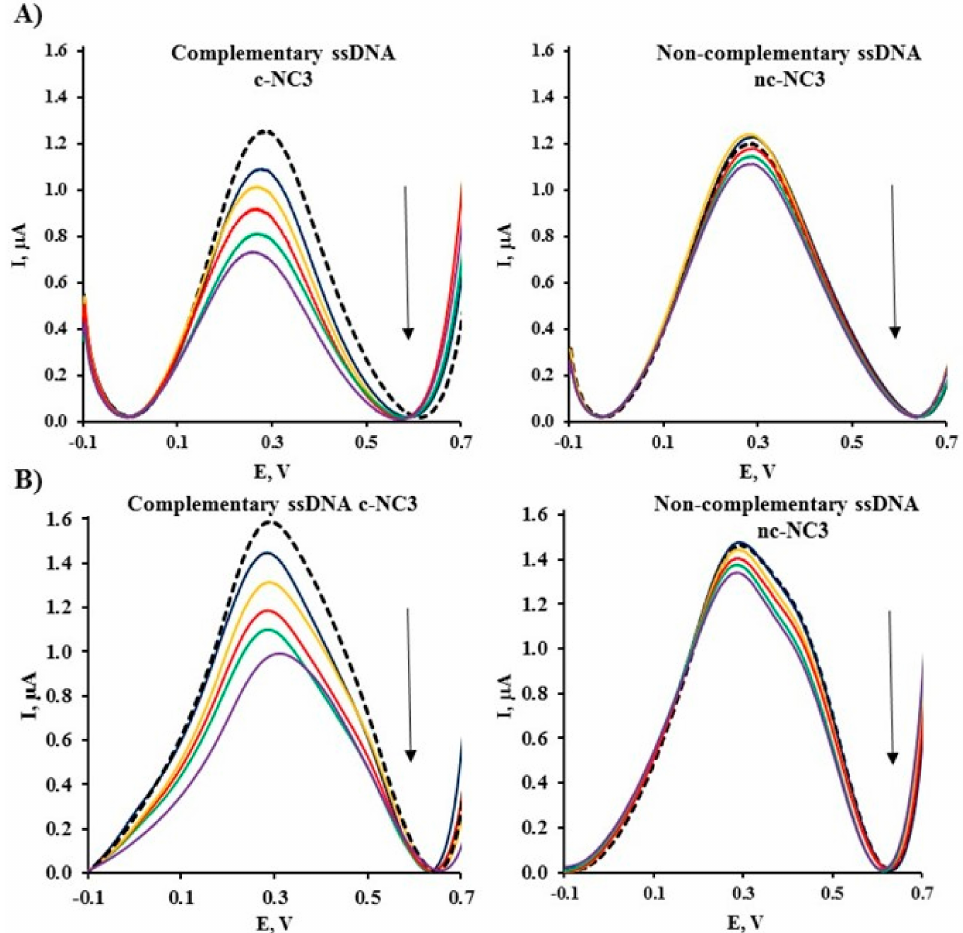
Figure 3. Representative Osteryoung square-wave voltammograms obtained for the gold electrode modified with: ( A ) TPY / Co(II) / TPY / ssDNA or ( B ) TPY / Cu(II) / TPY / ssDNA after hybridization with 20-mer complementary (c-NC3) and non-complementary (nc-NC3) ssDNA target at concentrations of 0 (dashed curve), 1, 5, 10, 15 and 20 fM. Bu ff er conditions: PBS, pH